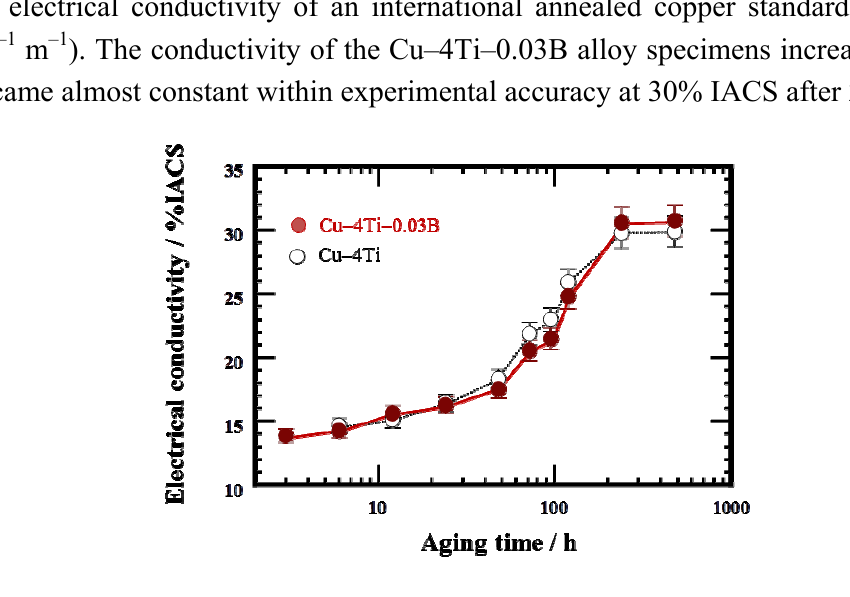
Figure 7. Electrical conductivity of Cu–4Ti–0.03B and Cu–4Ti alloys that were aged at 450 °C. The conductivity is expressed in % IACS, the percentile of the conductivity with respect to that of annealed pure